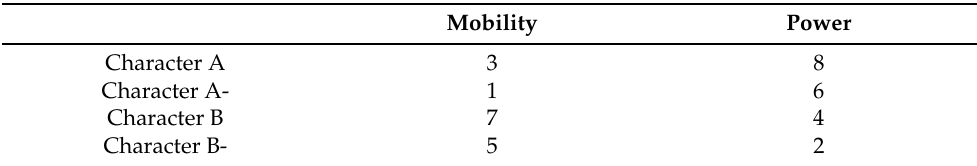
Table 1. Example of Primary Alternatives and a Decoy [48] (p.